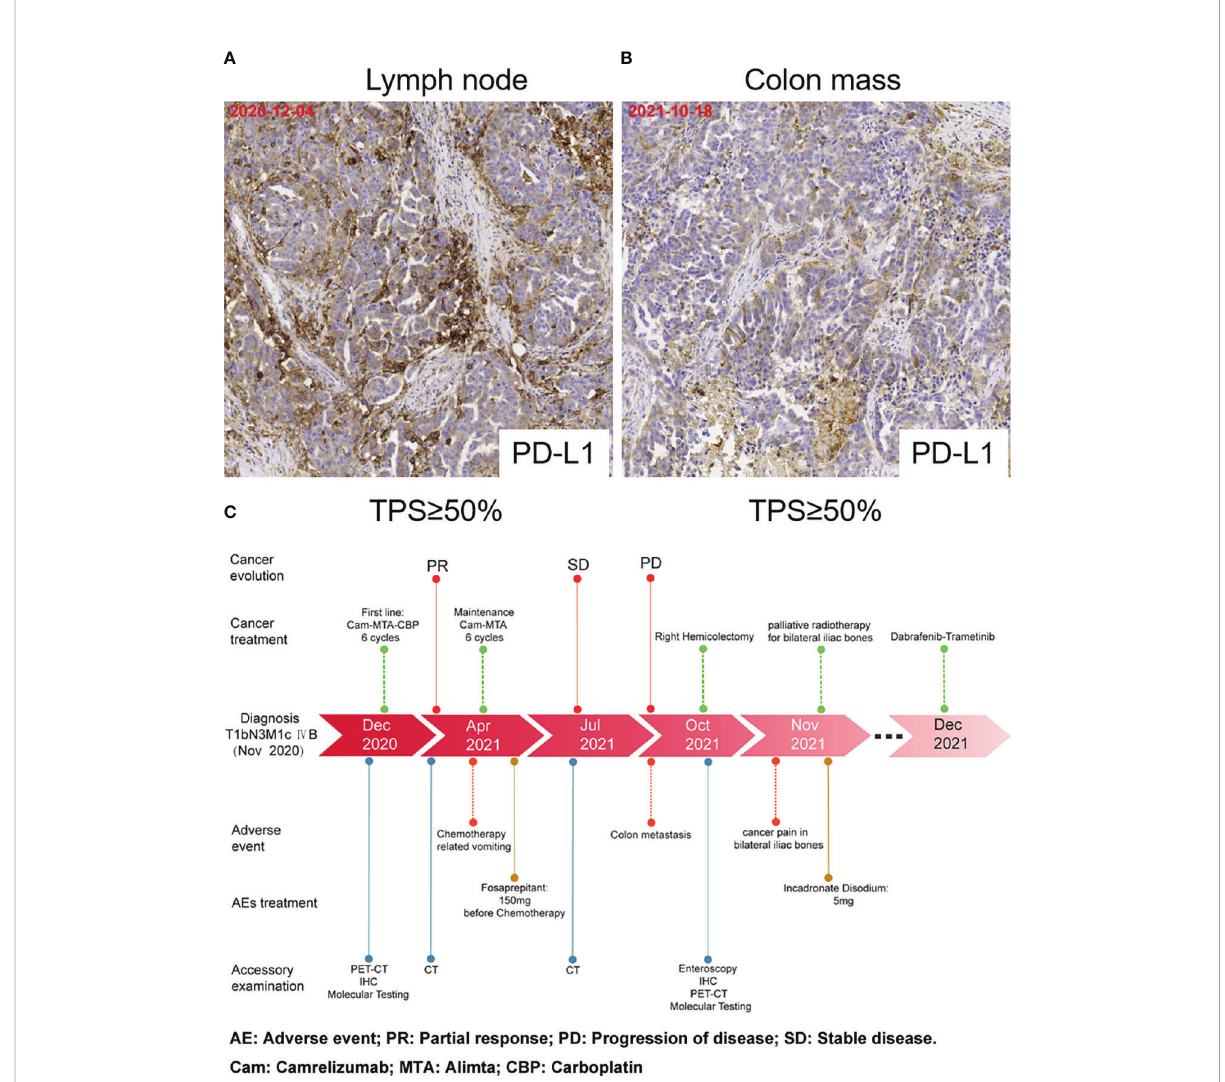
FIGURE 3 PD-L1 expression and timeline. (A) PD-L1 expression in lymph node biopsy tissues. (B) PD-L1 expression in the postoperative colon mass specimen. (C) Timeline of accessory examination 、 adverse events and their management during